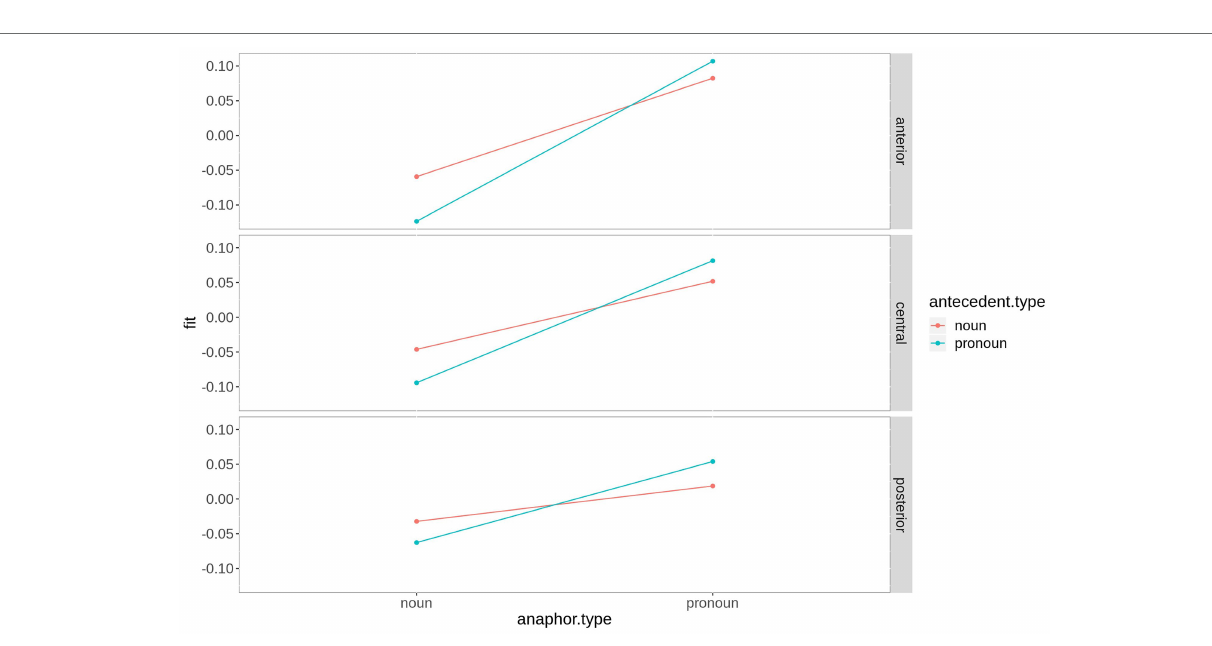
FIGURE 5 | Fitted values for the interaction saggitality*antecedent type*anaphor type in the P300 time window. For plotting purposes, the continuous variable saggitality was grouped into ROIs based on two-dimensional